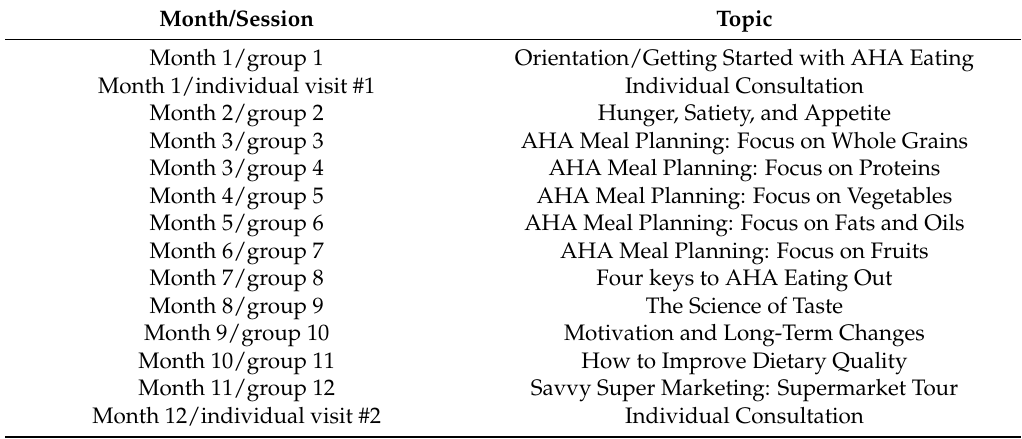
Table 1. American Heart Association (AHA) dietary intervention in the clinical study.